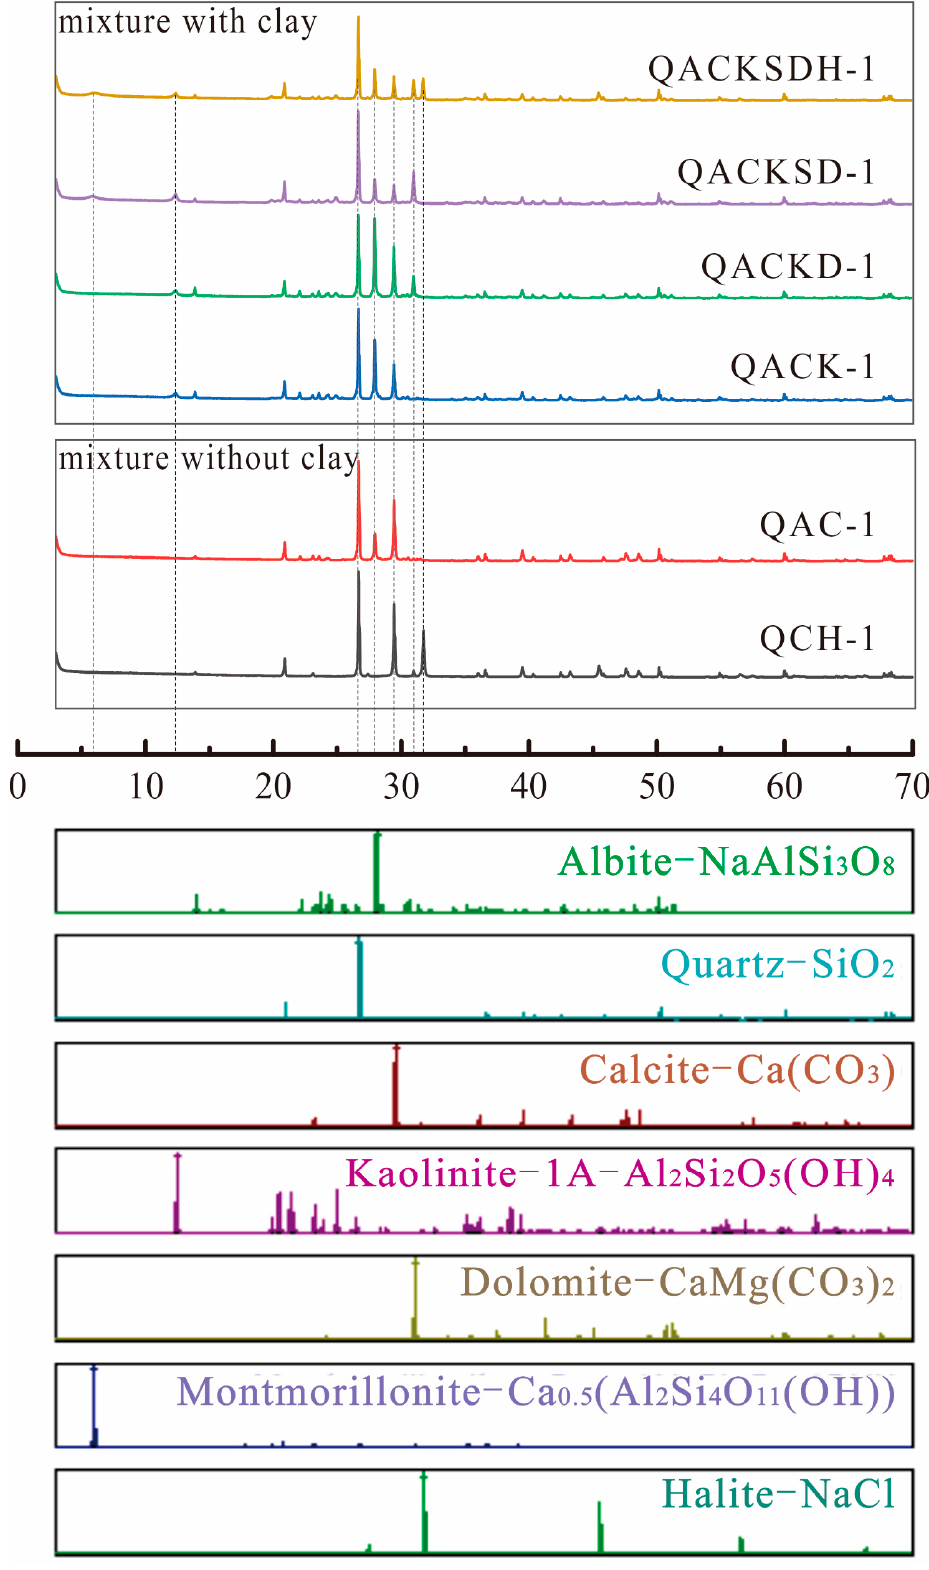
Figure 3. The representative XRD pa tt erns of the mixture samples.